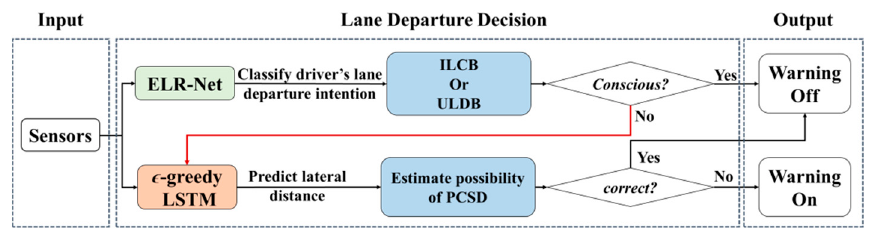
Figure 2. The structure of the proposed lane departure warning mechanism (LDWM).